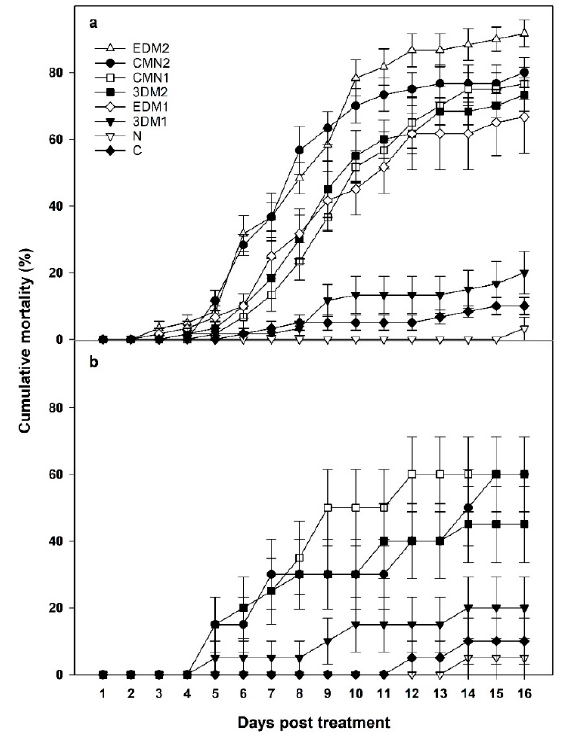
Figure 3. Cumulative mortality (%SE) of laboratory ( a ) and greenhouse ( b ) Melanoplus sanguinipes nymphs treated with Metarhizium brunneum F52 and Paranosema locustae . 3DM1 = 3 days’ exposure (STE) to M. brunneum at low concentration. 3DM2 = 3 days’ exposure (STE) to M. brunneum at high concentration. EDM1 = Continuous exposure (LTE) to M. brunneum at low concentration. EDM2 = Continuous exposure (LTE) to M. brunneum at high concentration. CMN1 = 3 days’ exposure (STE) to M. brunneum and P. locustae at low concentration. CMN2 = 3 days’ exposure (STE) to M. brunneum and P. locustae at high concentration. N = 3 days’ exposure to P. locustae . C = Untreated control.